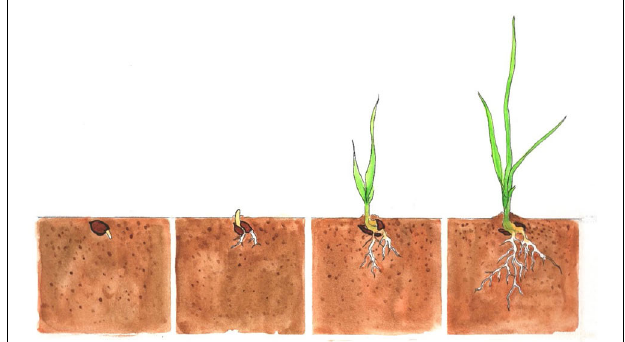
FIGURE 1 | The early seed and seedling life stages of plants. Germination is defined as the radicle emerging from the seed (first panel) whereas seedling emergence occurs when the cotyledon(s) of the seedling penetrates the soil surface (second panel). Establishment occurs when a seedling has transitioned from relying on the seed reserves to being a photosynthetic autotroph (third panel) (Larson et al., 2015). Survival occurs if the plant is still alive by the end of the growing season (fourth panel). Watercolor by Corey